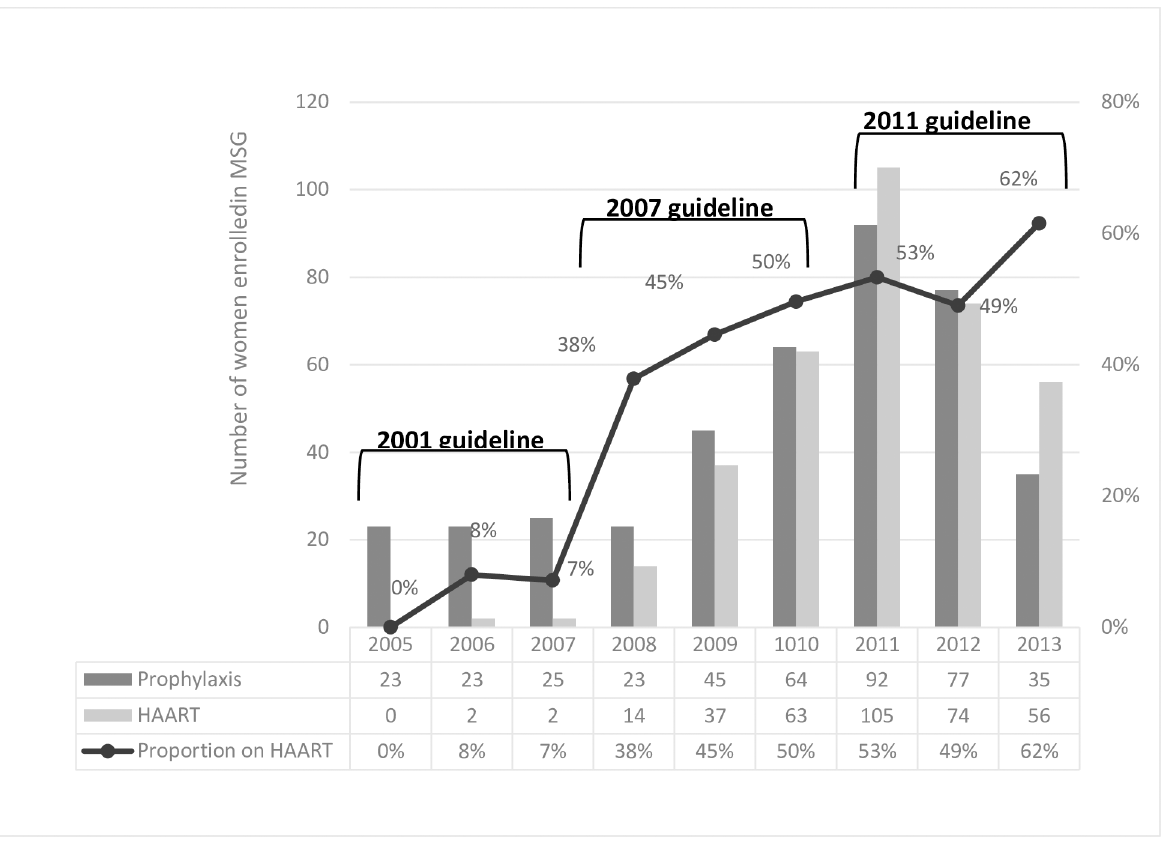
Fig 1. Trend data showing proportions of women receiving HAART over the nine years in the MSG programme, Addis Ababa.